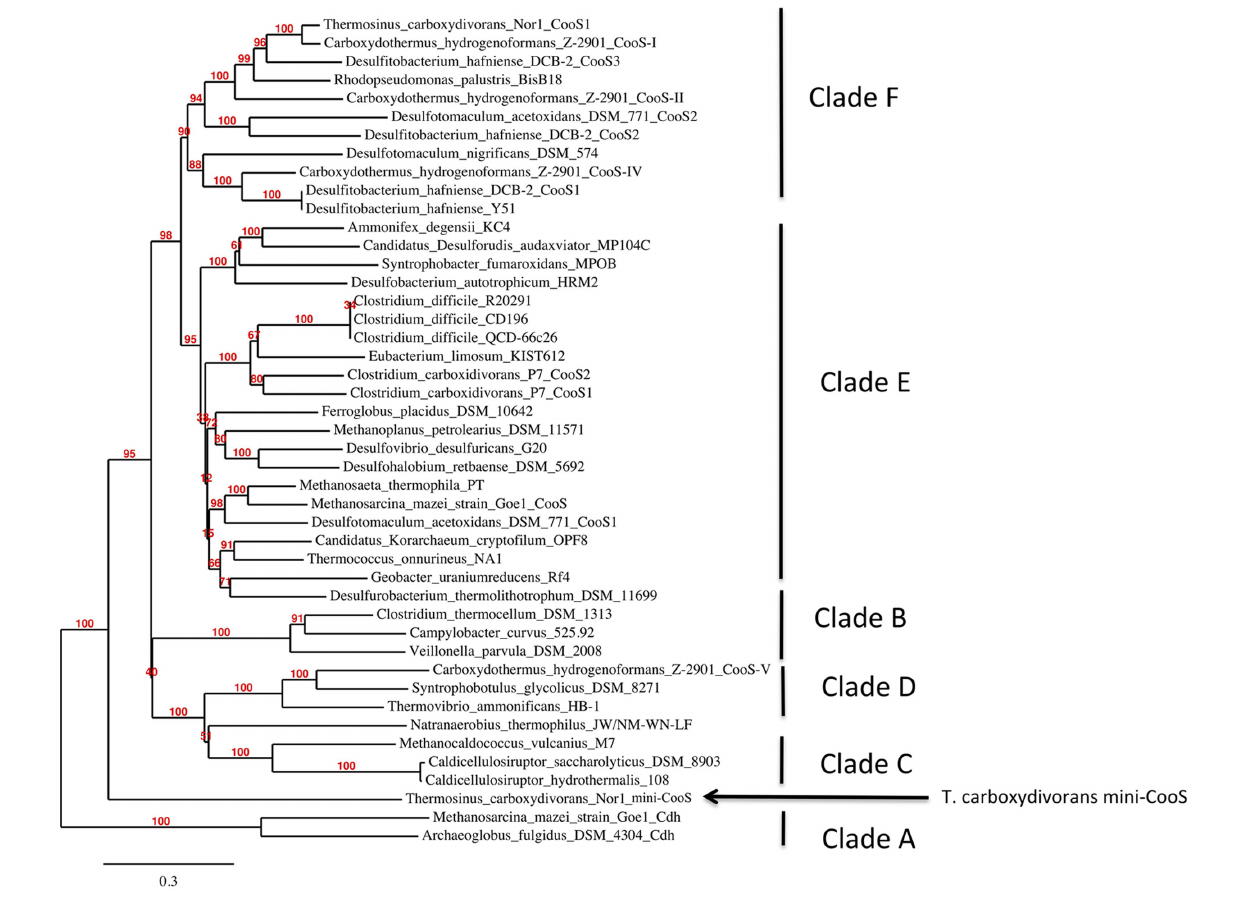
FIGURE 3 | Phylogenetic position of the mini-CooS from Thermosinus carboxydivorans . A maximum likelihood tree was built from a MUSCLE alignment of representative sequences selected from all of the [Ni,Fe]-CODH